Question: Sum up the contents of this chart in one sentence.
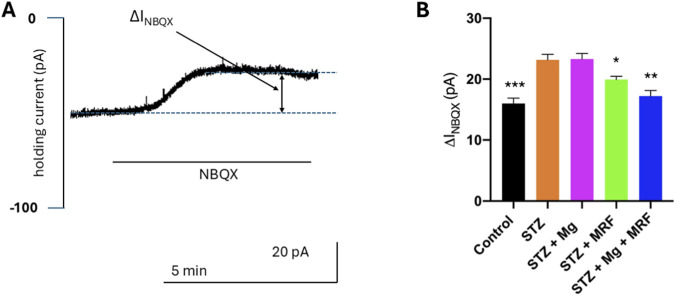
Answer: NBQX-sensitive tonic current in vlPAG. (A) Representative voltage-clamp trace at V hold = −70 mV. Bath application of NBQX (10 µM) produces an outward shift in the holding current, revealing the NBQX-sensitive tonic AMPA component (ΔI NBQX ). (B) Summary of ΔI NBQX (pA). Statistical analysis was performed using Welch’s ANOVA followed by Dunnett’s multiple comparisons test. *** p < 0.001, ** p < 0.01, * p < 0.05 vs. STZ. Values are presented as mean ± SEM; n = 6 animals per group. Scale bar: 5 min, 20 pA (A) .